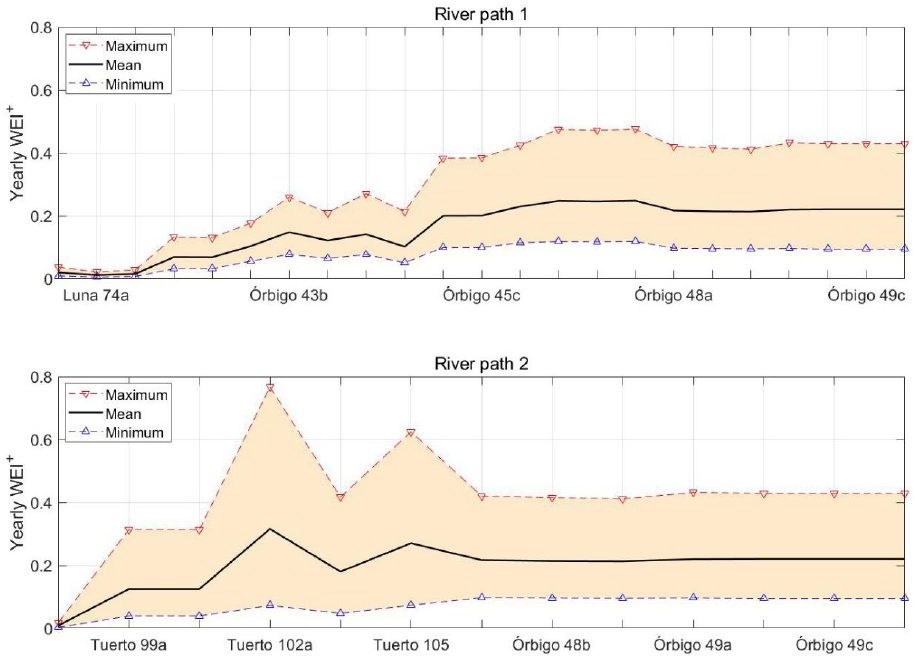
Figure 5. Variation of the yearly WEI + along the two river paths indicated in Figure 1. The maximum, mean and minimum values are marked in red, black and blue, respectively. On the other hand, the highest values of the yearly WEI + along river path 2 are ob- tained in the upper part of the basin (Tuerto river stretch, Figure 5), which indicates that this river stretch is subjected to greater water stress than the Ó rbigo River. In fact, in some years, the yearly WEI + values in the Tuerto River are greater than 0.6, reaching a maximum value of 0.76 in the Tuerto 102a river stretch. Thus, if new demands are projected in the Ó rbigo River basin, it would be more recommendable to supply these demands with wa- ter resources from the Ó rbigo River than from the Tuerto River. For this reason, the fol- lowing section (Section 4.2) analyzes the temporal evolution of the yearly and monthly WEI + in three river stretches of the Ó rbigo River in the upper, lower and middle parts of the basin. 4.2. Temporal Evolution of the Water Exploitation Index Figure 6 shows the temporal evolution of the yearly WEI + in three stretches of the Ó rbigo River in the upper, middle and lower parts of the basin, which are indicated in Figure 3. It can be observed that the yearly WEI + values experience a significant variability between years. These yearly WEI + values are higher in the middle and lower parts of the basin (Ó rbigo 46 and Ó rbigo 49d) than in the upper part (Ó rbigo 43a). Thus, along the Ó rbigo River, the stretches of the upper part are subjected to lower levels of water stress, so that they could be more suitable to satisfy possible new water demands (and/or greater values of environmental flows) in the future. However, the monthly evolution of the water evolution index should also be considered to ensure that the regulation capacity of the upstream reservoirs (Barrios de Luna and Selga de Ordás, Figures 3 and 4) is enough to satisfy all the water demands and environmental restrictions throughout the year.